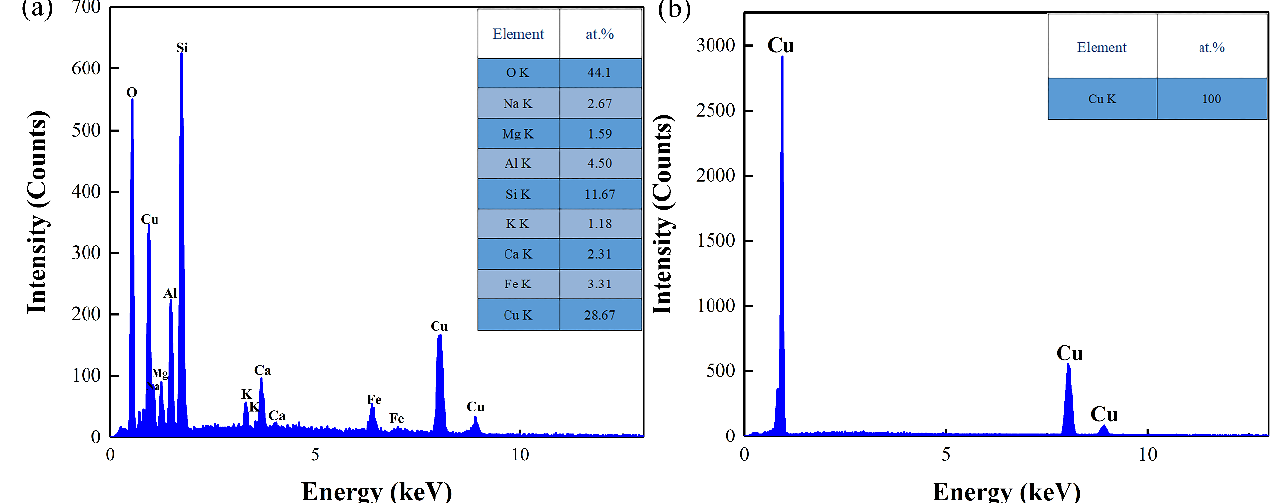
Figure 11. EDS patterns of signed points in Figure 10: ( a ) point A; ( b ) point